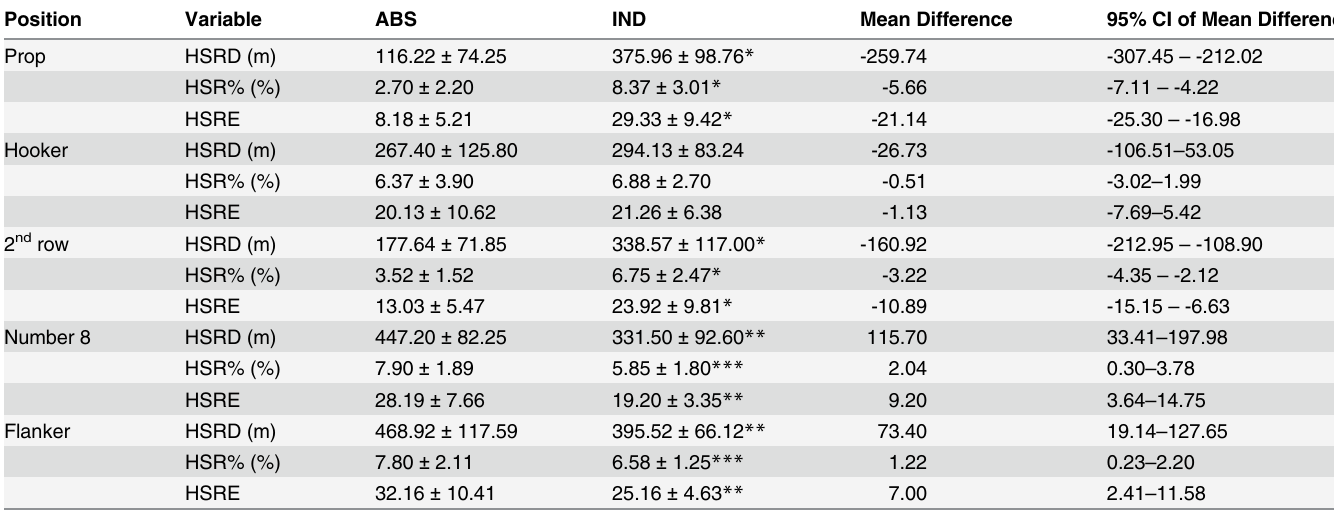
Table 5. ABS vs IND HSR demands of forward position sub-categories.